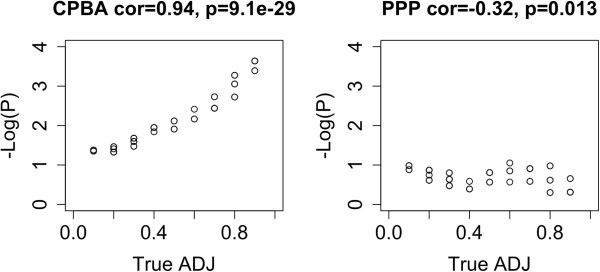
Simulated CPBA versus PPP Analysis. Scatterplot of the −Log10(P) values versus the true adjacency values obtained from 0/1 block diagonal matrix by re-setting a few other entries from 0 to 1. These changed values are shown along with the resulting −Log10(P) values obtained using CPBA and PPP.